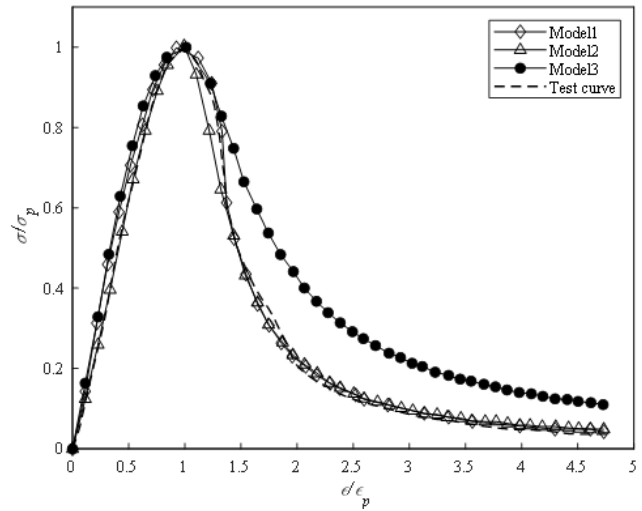
Figure 17. Prediction and test results.